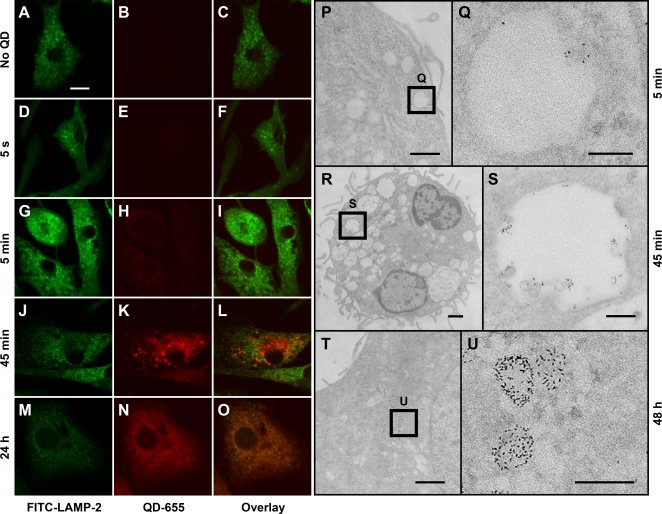
Compartmentation of single QDs inside endocytic vesicles and lysosomes.(A–O) Confocal images showing colocalization of QD-containing vesicles with the lysosomal protein LAMP-2 inside bone marrow-derived DCs after different times of incubation in QD-containing medium as indicated on the left. Columns show LAMP-2 staining (green), QD staining (red), and overlays of LAMP-2 and QD images, respectively. Scale bar in A–O = 10 µm. (P–U) Electron mircographs showing individual QDs within DCs, and associated structures and location after different times of incubation in QD-containing media as indicated on the right.. Indicated regions in P, R, and T, respectively, shown at higher magnification. Note the correspondence between electron micrographs P, R, and T with confocal images I, L and O, respectively. Scale bars in P, R, and T = 1 µm and in Q, S, and U = 200 nm.